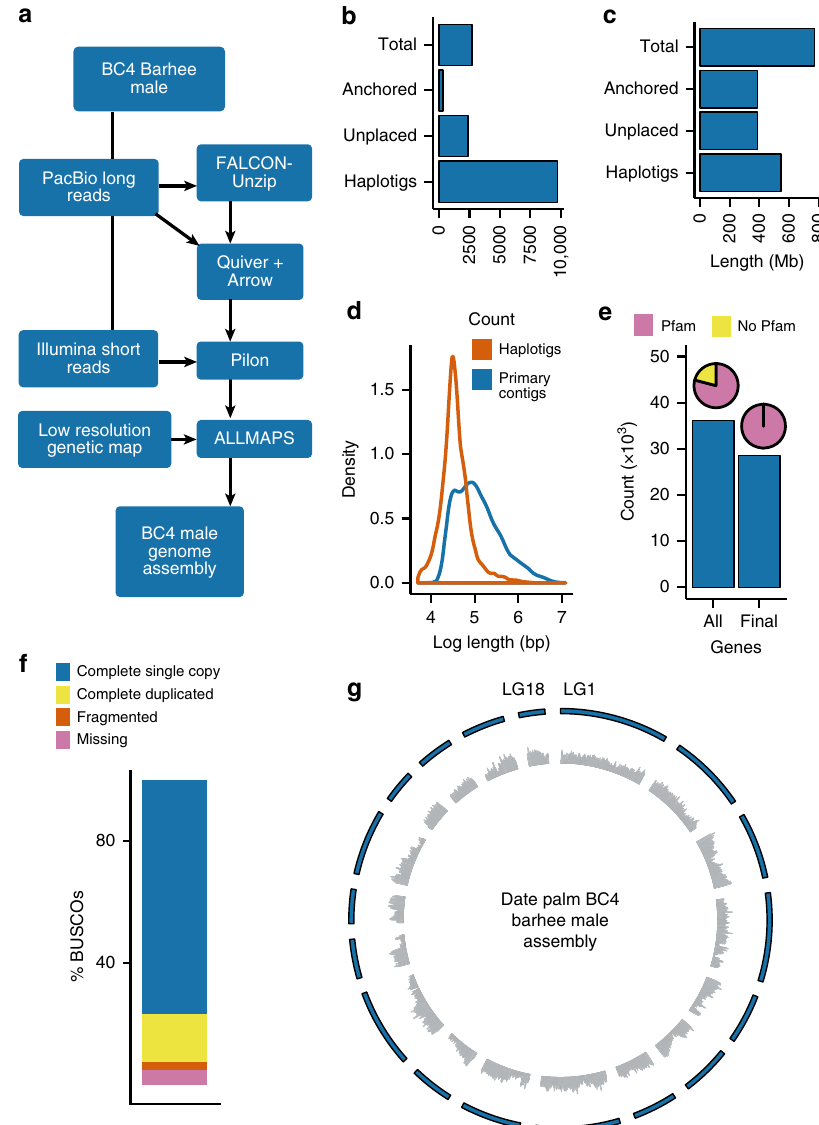
Fig. 1 BC4 male date palm genome assembly. a Genome assembly work fl ow. b Total (anchored + unplaced) numbers of contigs. c Total (anchored + unplaced) contig lengths. d Length distribution of haplotigs and primary contigs generated by FALCON-Unzip. e Gene counts in the original (All) gene set and high con fi dence (Final) set. Pie diagrams indicate the percentage of genes with Pfam domains in each set. f Summary of BUSCO analysis of assembly completeness. g Circos diagram of 18 linkage groups showing gene density (inner) and linkage group ideograms (outer). Linkage groups are numbered in clockwise order beginning with LG1. Gene densities were calculated in sliding windows of 200 kb with step size of 50 kb. The source data underlying Fig. 1b – g are provided as a Source Data fi le